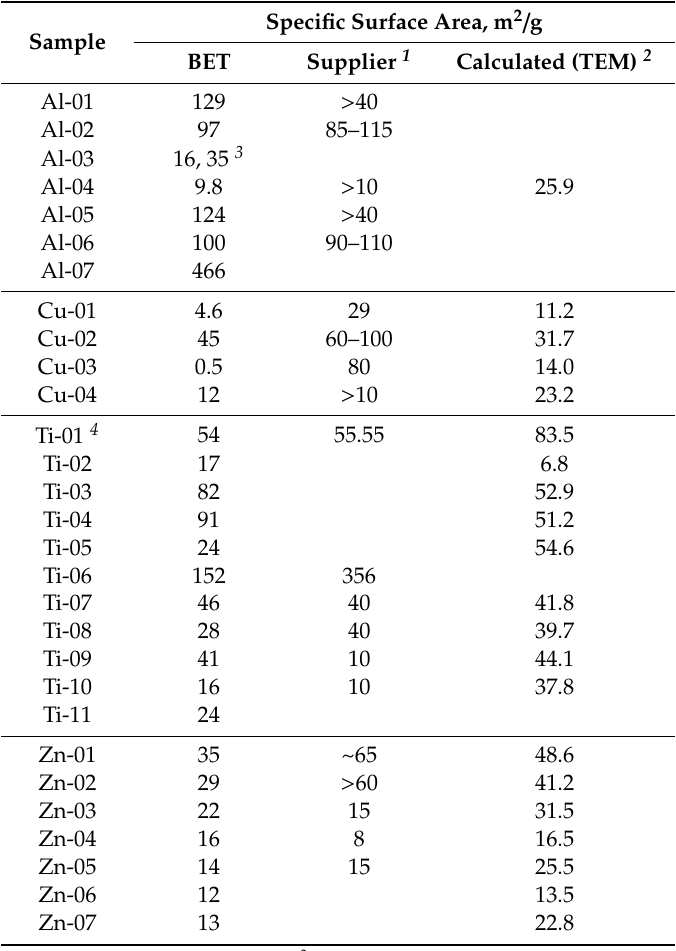
Table 4. Comparison of specific surface area measured by the BET method with supplier information and the approximate SSA values calculated from the TEM equivalent